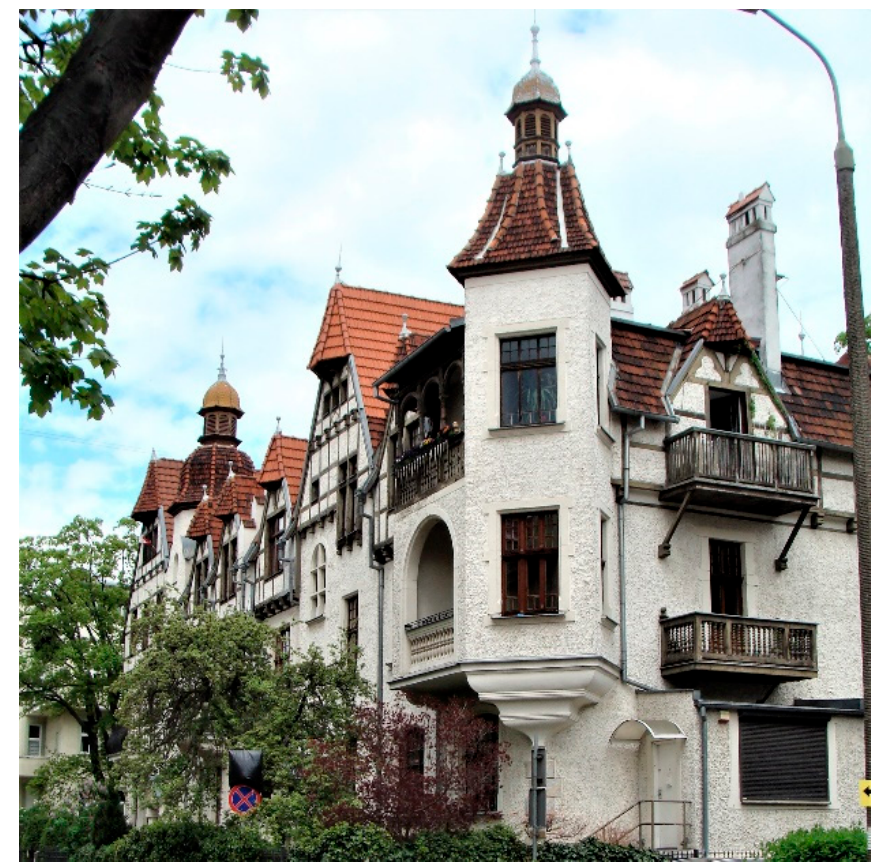
Figure 2. Tenement house from 1905 in Sopot. Source: A. Taraszkiewicz. After the Treaty of Versailles in 1920, Sopot became part of the Free City of Danzig, and with the onset of World War II was incorporated into the Third Reich [27,29]. Liberated after World War II in 1945, Sopot was incorporated into Poland. The warfare did a lot of damage to the town, not all of which has been repaired. The destruction concerned not only the material substance, but also the cultural continuity, which was broken by the post-war exchange of society. At the end of the war, almost all pre-war inhabitants of Sopot, who were of German nationality, fled from the Red Army